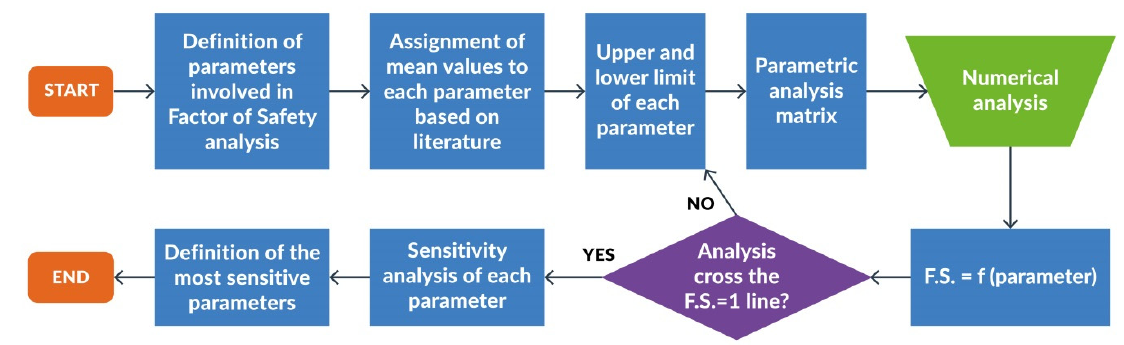
Figure 1. Methodology flowchart.